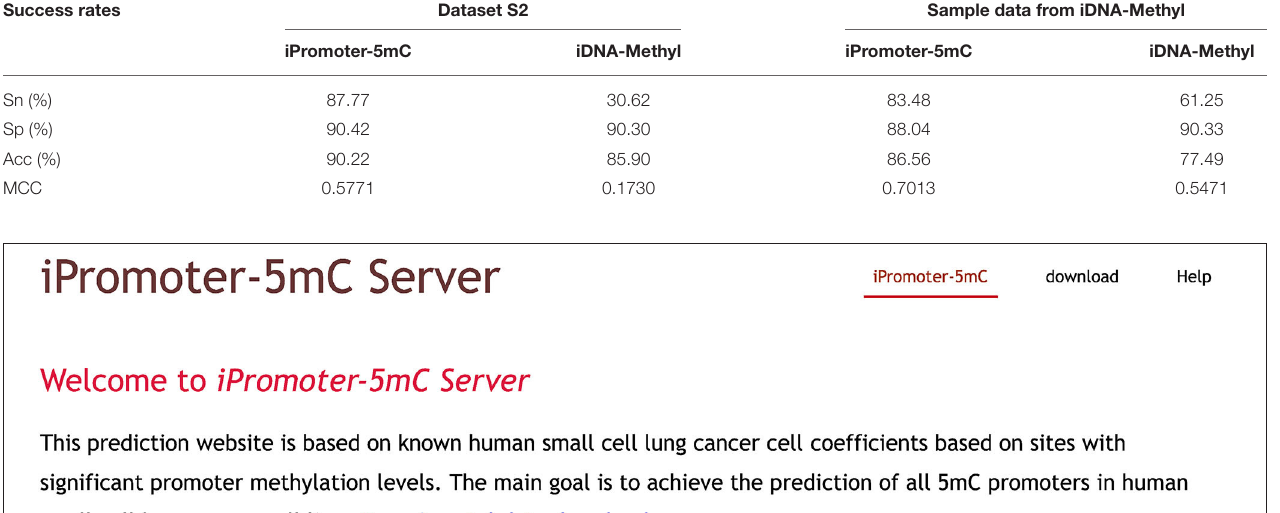
importantly, the sizes of their benchmark dataset are significantly different. The sample size of iPromoter-5mC is far greater than iDNA-Methl’s, which enables our model to obtain better correlation between sequences, causing the phenomenon that